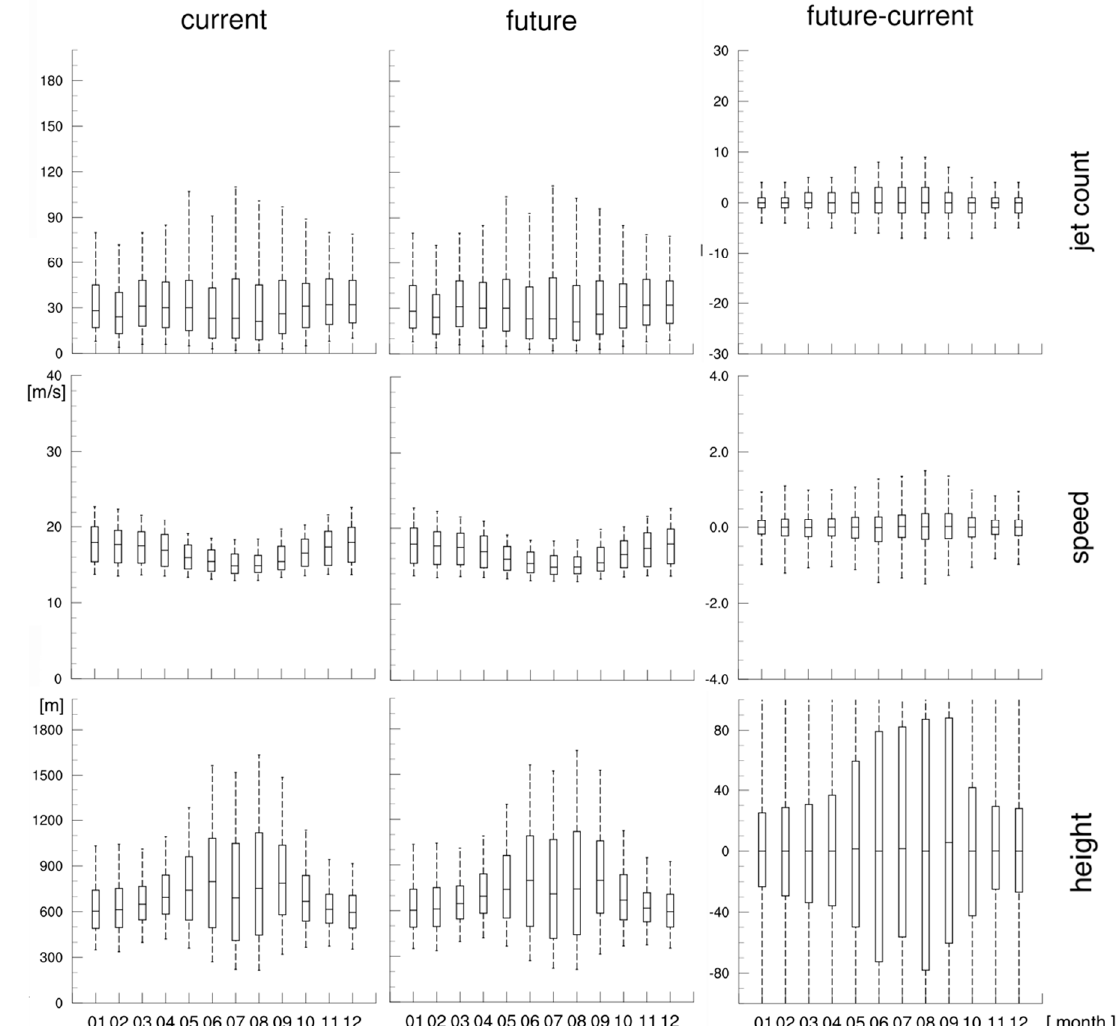
Figure 2. Box-whisker plots of simulated low-level jets (LLJ) properties across all grid points for each month at 00UTC under the current and future LULC conditions and their differences. The box denotes the 25% and 75% quartiles, the horizontal line is through the median, and the whiskers indicate the 5% and 95% quartiles, respectively.